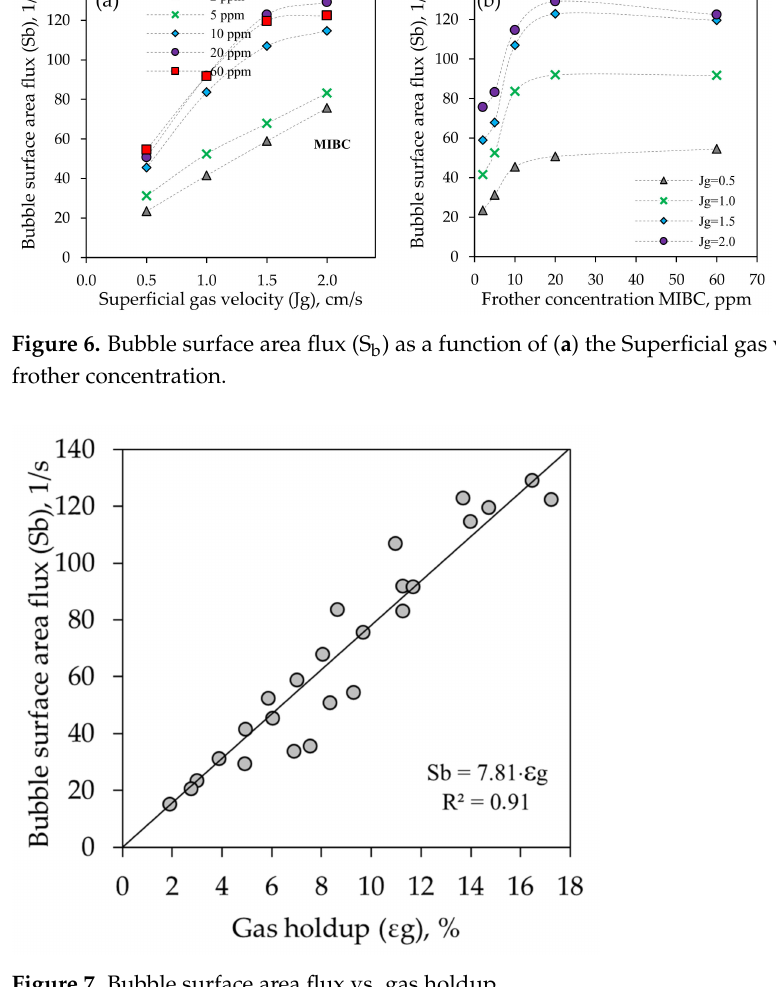
Figure 7. Bubble surface area flux vs. gas